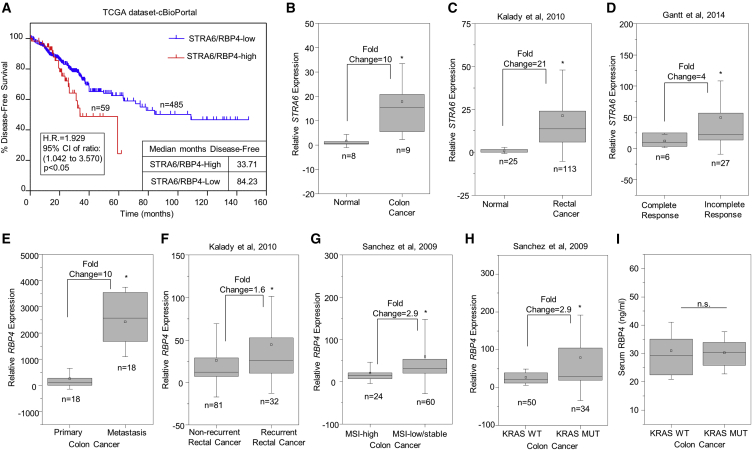
STRA6 and RBP4 Are Upregulated in Colorectal Cancer Patients(A) Kaplan-Meier plot showing differences in disease-free survival percentages between colorectal cancer patients with high or low expression of STRA6 or RBP4. TCGA dataset, available through cBioPortal, was used. H.R., hazard ratio; CI, confidence interval.(B and C) Levels of STRA6 expression in normal versus adenocarcinoma samples (B) and in normal versus rectal cancer patients (C).(D) STRA6 mRNA levels in samples from patients showing complete or partial pathological response to chemoradiation.(E) Data analysis showing levels of RBP4 mRNA in matched samples from primary and liver metastasis of colon cancer.(F) Levels of RBP4 mRNA in rectal cancer patient samples grouped by 3-year recurrence.(G and H) Levels of RBP4 mRNA in colon tumors with high versus low/stable microsatellite instability (MSI) (G) and in tumors with KRAS mutation (MUT) versus the wild-type (WT) (H).(I) RBP4 levels measured in serum of KRAS WT (n = 16) and KRAS mutant (n = 14) patients.Boxes represent the sample range and whiskers are 1 SD from the mean. Squares within the boxes represent mean values. ∗p < 0.05; n.s., not significant